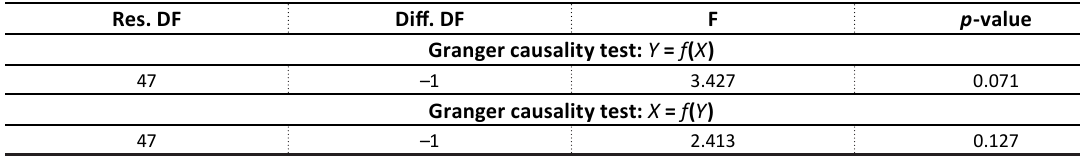
Table E2. Granger causality test: rank ( X ) and SC ( Y ) Res. DF Diff. DF